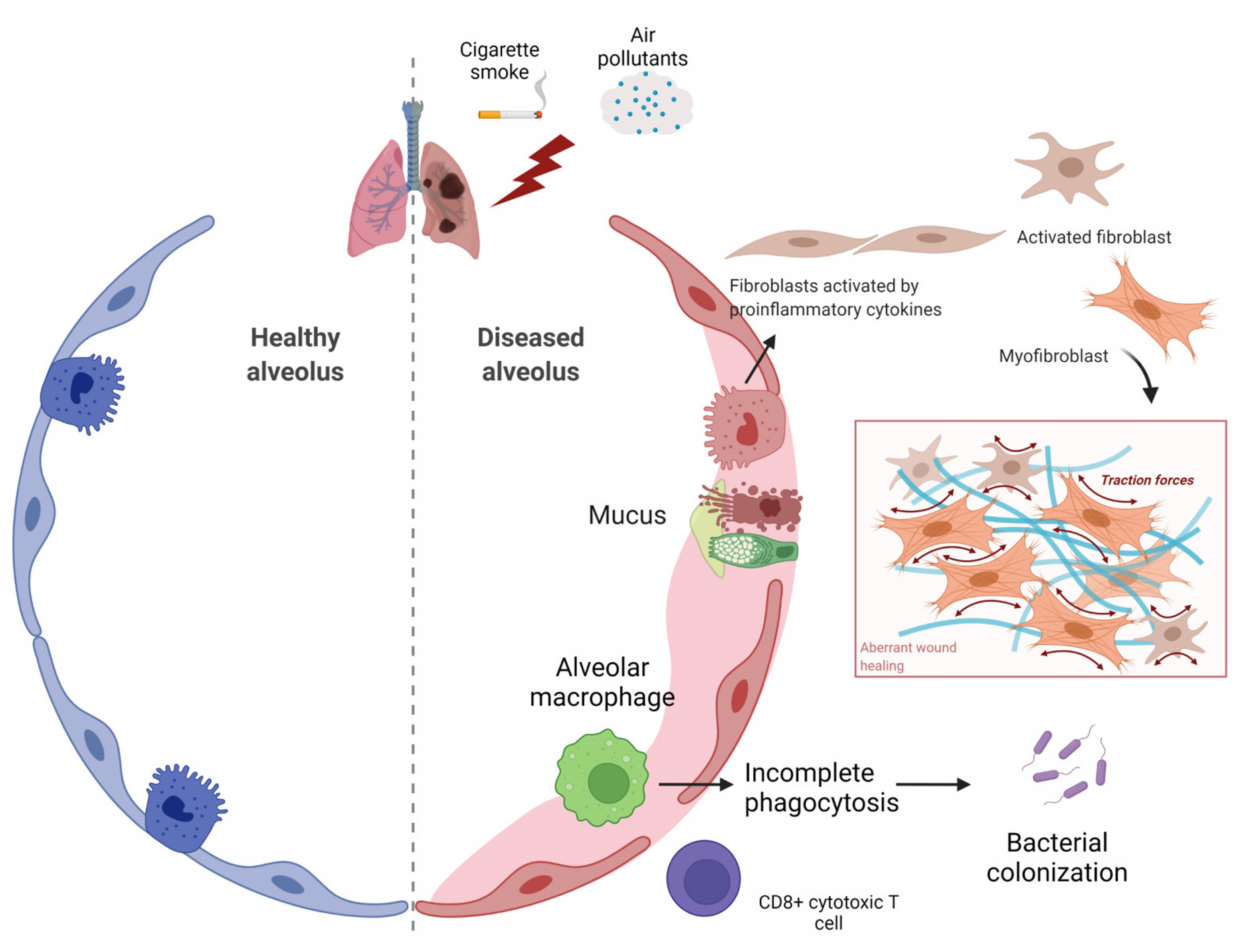
Figure 2. Airway obstruction and inflammatory cells involved in COPD. In chronic obstructive pulmonary disease (COPD), decline in lung function and airflow obstruction due to cigarette smoke and various air pollutants results in disruption of alveolar wall attachments as a result of emphysema formation and airway luminal occlusion by mucus hypersecretion. Both inflammation and fibrosis lead to narrowing of small airways via thickening of the bronchiolar wall. Figure created using BioRENDER.com. Accessed on 18 November